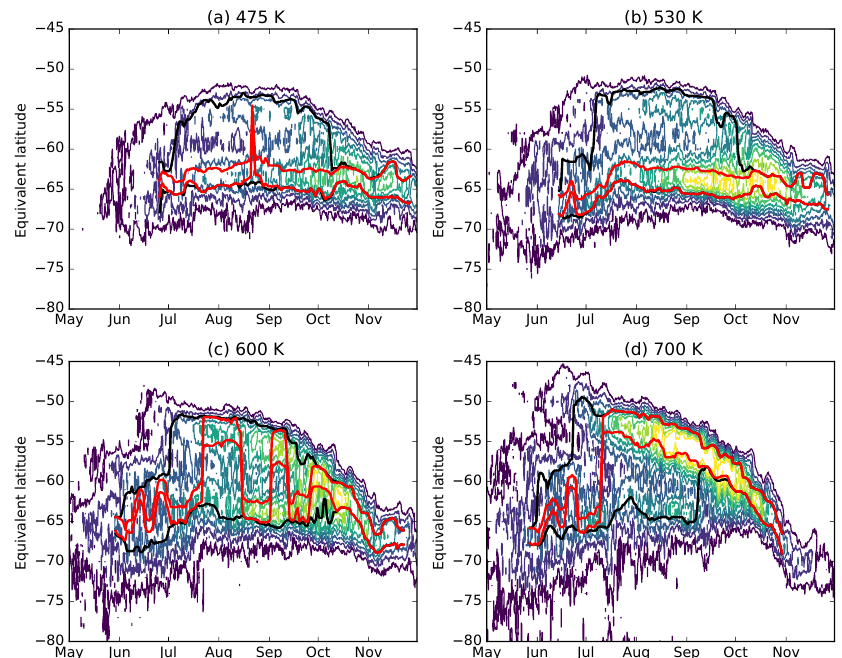
Figure 11. Example showing evolution of PV gradient (coloured contours) and 7-day running average of inner and outer edges diagnosed using (red) the Nash et al. (1996) algorithm or (black) the BI algorithm presented here, during 2007 for four ERA-Interim heights. Where the black line is not visible, it is in the same position as the red line. Contours of PV gradient are given in 0.15sPVU steps from 0.3 to 1.5sPVU.